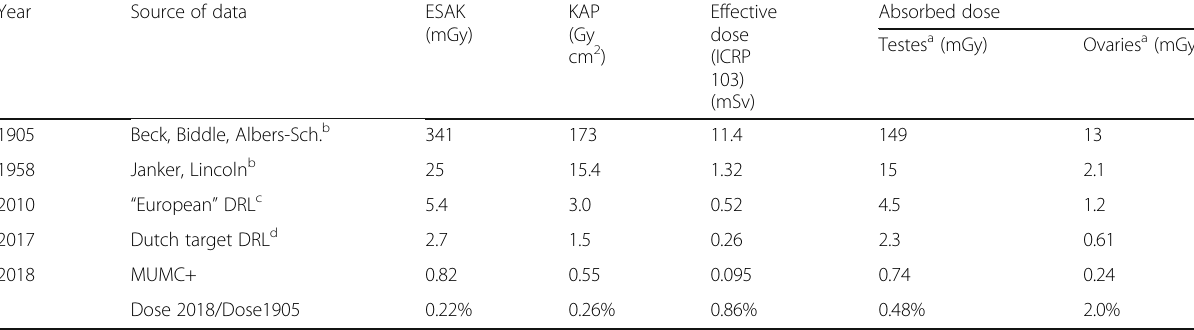
Table 3 Mean dose data AP pelvic radiograph in absence of gonad shielding